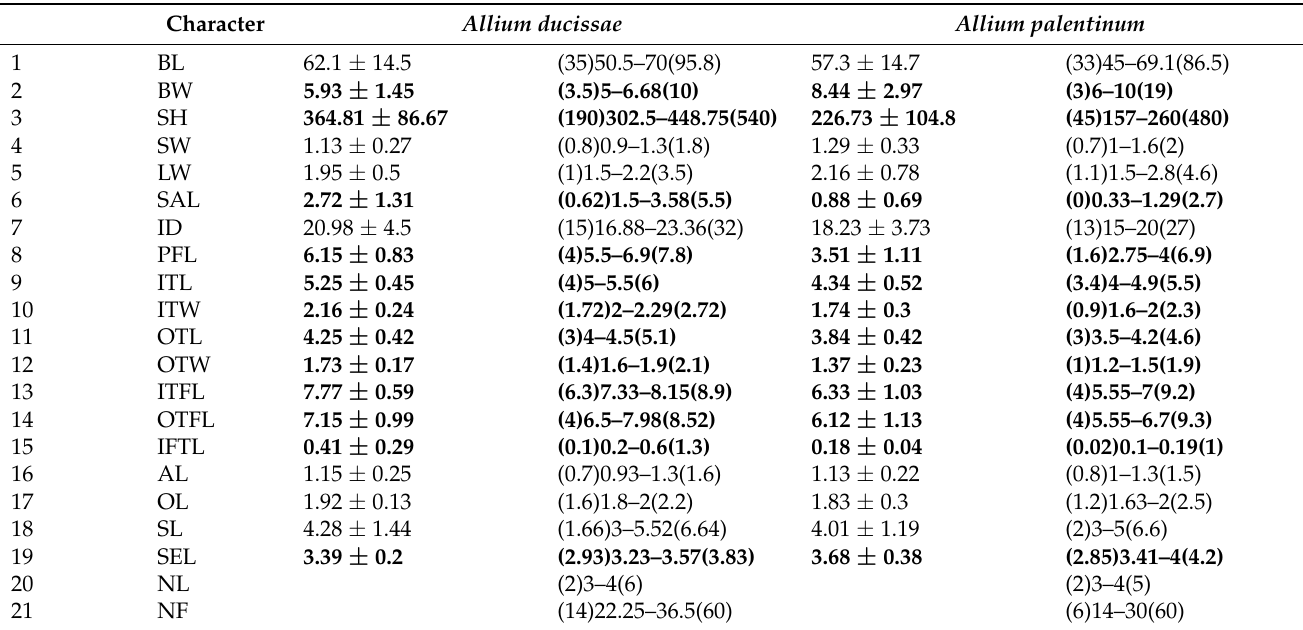
Table 2. Comparisons of morphological characters between Allium ducissae and A. palentinum . Quan- titative continuous characters are expressed in mm and are reported as mean ± standard deviation and 25–75 percentiles (extreme values in brackets). For quantitative discrete cardinal characters, 25–75 percentiles are given (extreme values in brackets). Significantly different character states are shown in bold ( p <